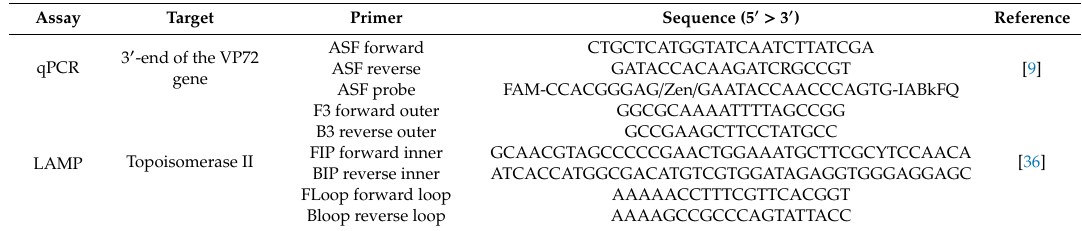
Primer sequences used for the qPCR and loop-mediated isothermal amplification (LAMP)